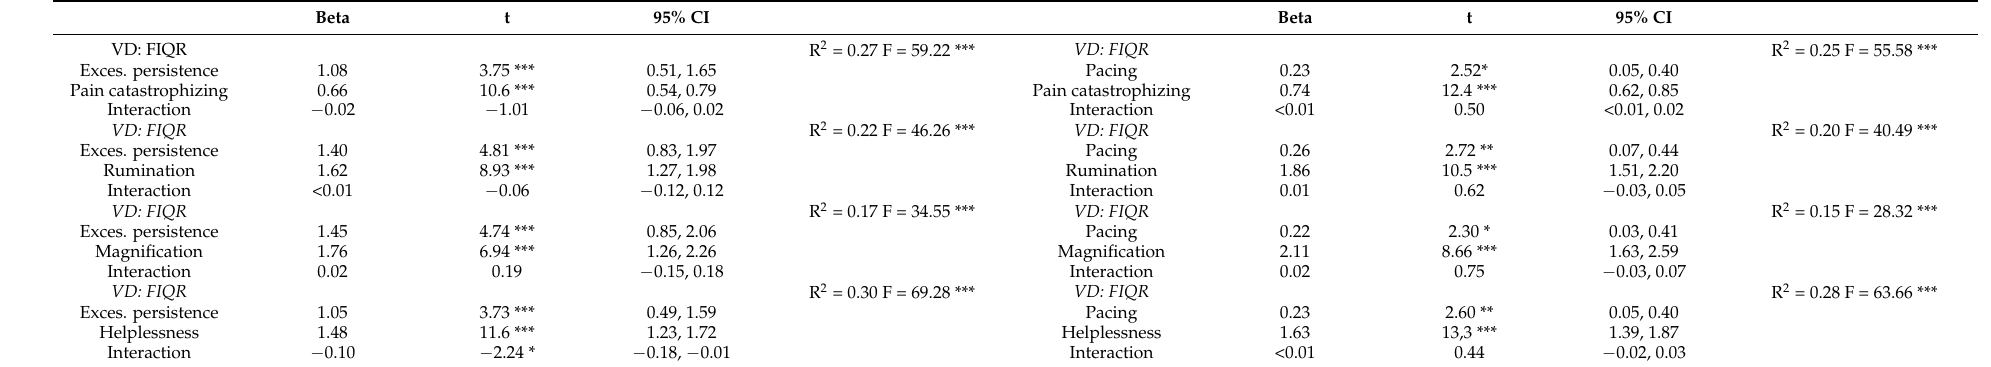
Table 5. Prediction of fibromyalgia impact from excessive persistence and pacing, pain catastrophizing (total score and dimensions), and their